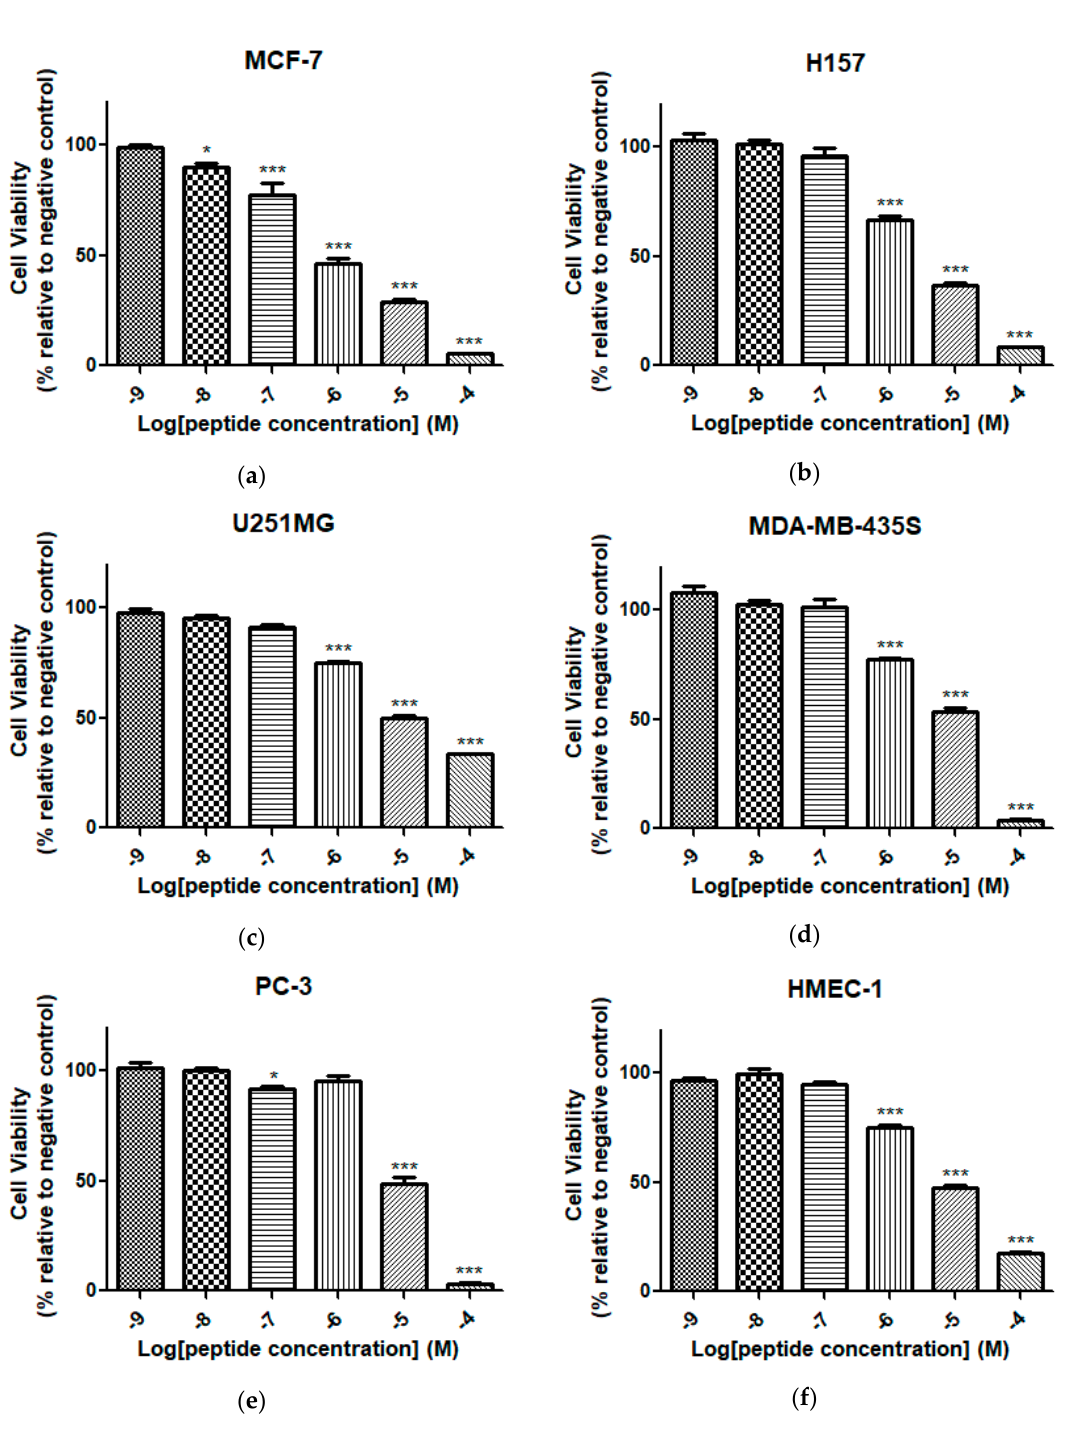
Figure 11. The effects of Dermaseptin-PH on proliferation of human cancer cell lines ( a ) MCF-7; ( b ) H157; ( c ) U251MG; ( d ) MDA-MB-435S; and ( e ) PC-3 and ( f ) human dermal microvascular endothelium cell HMEC-1; after treatment with Dermaseptin-PH for 24 h at a range of concentrations from 10 − 9 to 10 − 4 M. The levels of significance are: * p < 0.05, *** p < 0.001. The negative control group was treated with relevant serum-free culture medium.